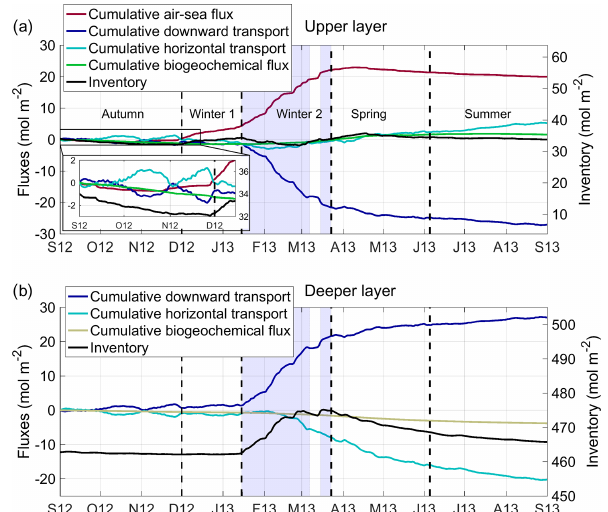
Figure 8. Time series from September 2012 to September 2013 of the oxygen inventory (black line) and cumulative air–sea flux (red line), downward transport (dark blue), lateral transport (positive val- ues: input for the convection area, light blue), and biogeochemical flux (green line) in the (a) upper (surface to 150m) and (b) deeper (150m to bottom) layer. Unit:molm − 2 .